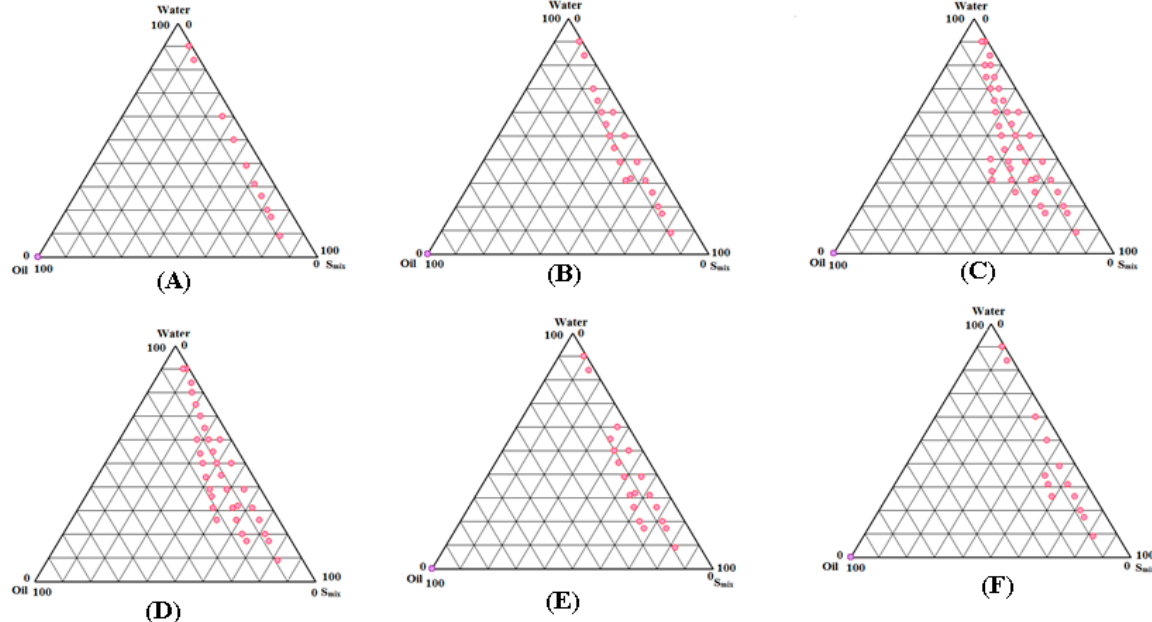
Figure 1. Pseudo-ternary phase diagrams for the preparation of the SNEDDS zones of LUT for oil phase (Capryol-PGMC),